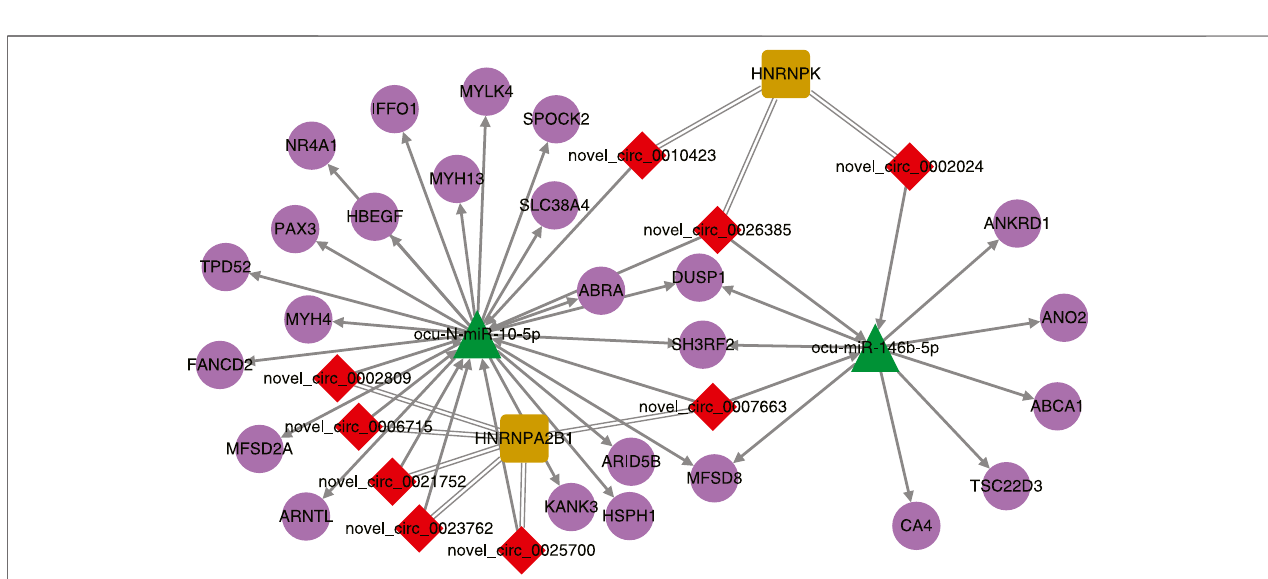
FIGURE 4 | Interaction network of differentially expressed circRNAs, miRNAs, their target genes, and binding proteins.